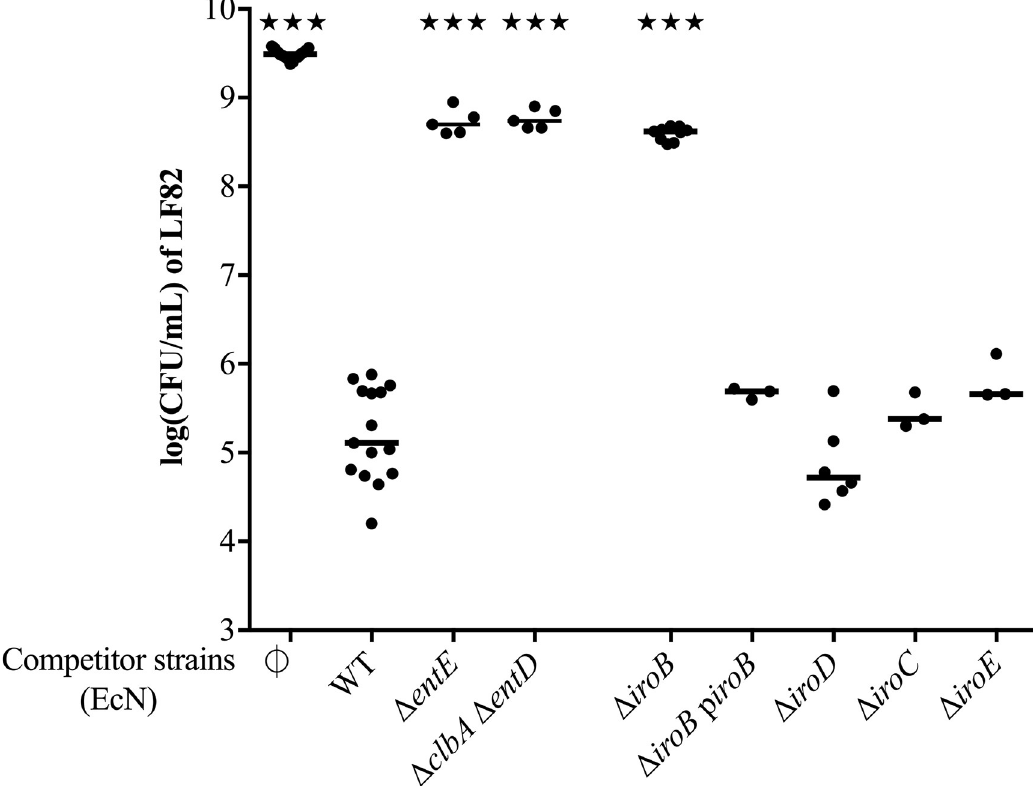
Fig 3. Role of siderophores in EcN antibacterial activity on LF82. Colony forming unit (CFU) counts of E . coli LF82 following a 24-hour co-culture in M63 medium with wild-type (WT) E . coli strain Nissle 1917 (EcN), EcN mutant for entE that encodes the enterobactin synthase E, and the double mutant for the phosphopantetheinyl transferases ClbA and EntD; EcN mutant and complemented strain for the glucosyltransferase IroB, the cytoplasmic esterase IroD, the periplasmic esterase IroE, and the export protein IroC. LF82 was also cultured alone as a control ( ∅ ). The medians and individual results of independent experiments are shown. One-way ANOVA and Bonferroni post-tests in comparison with co-culture with WT; $$$ P < 0.001.